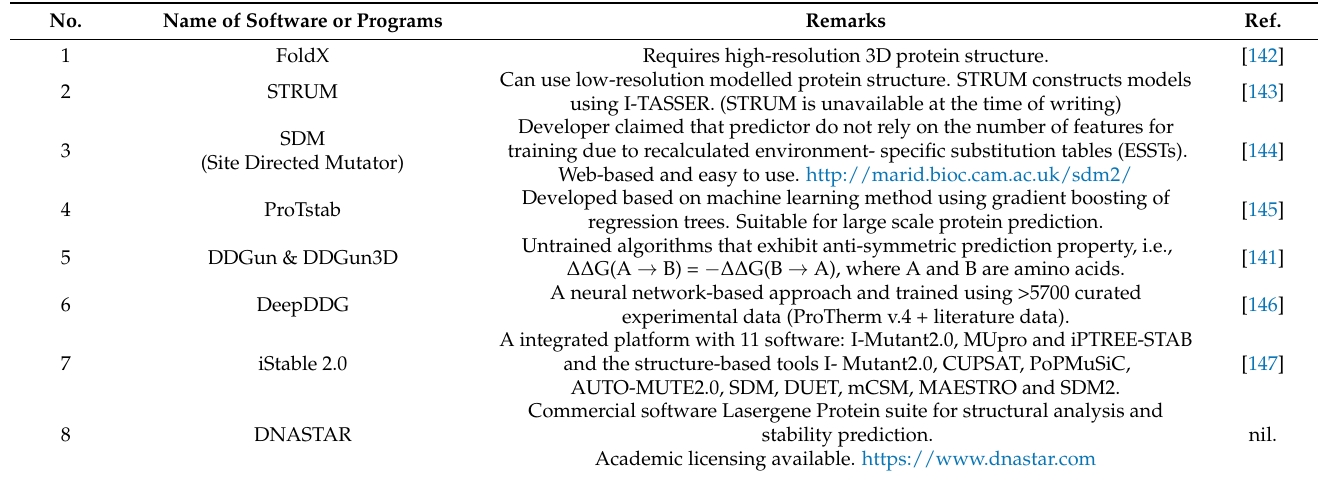
Table 8. List of software or programs for simulating protein macromolecules for thermostability